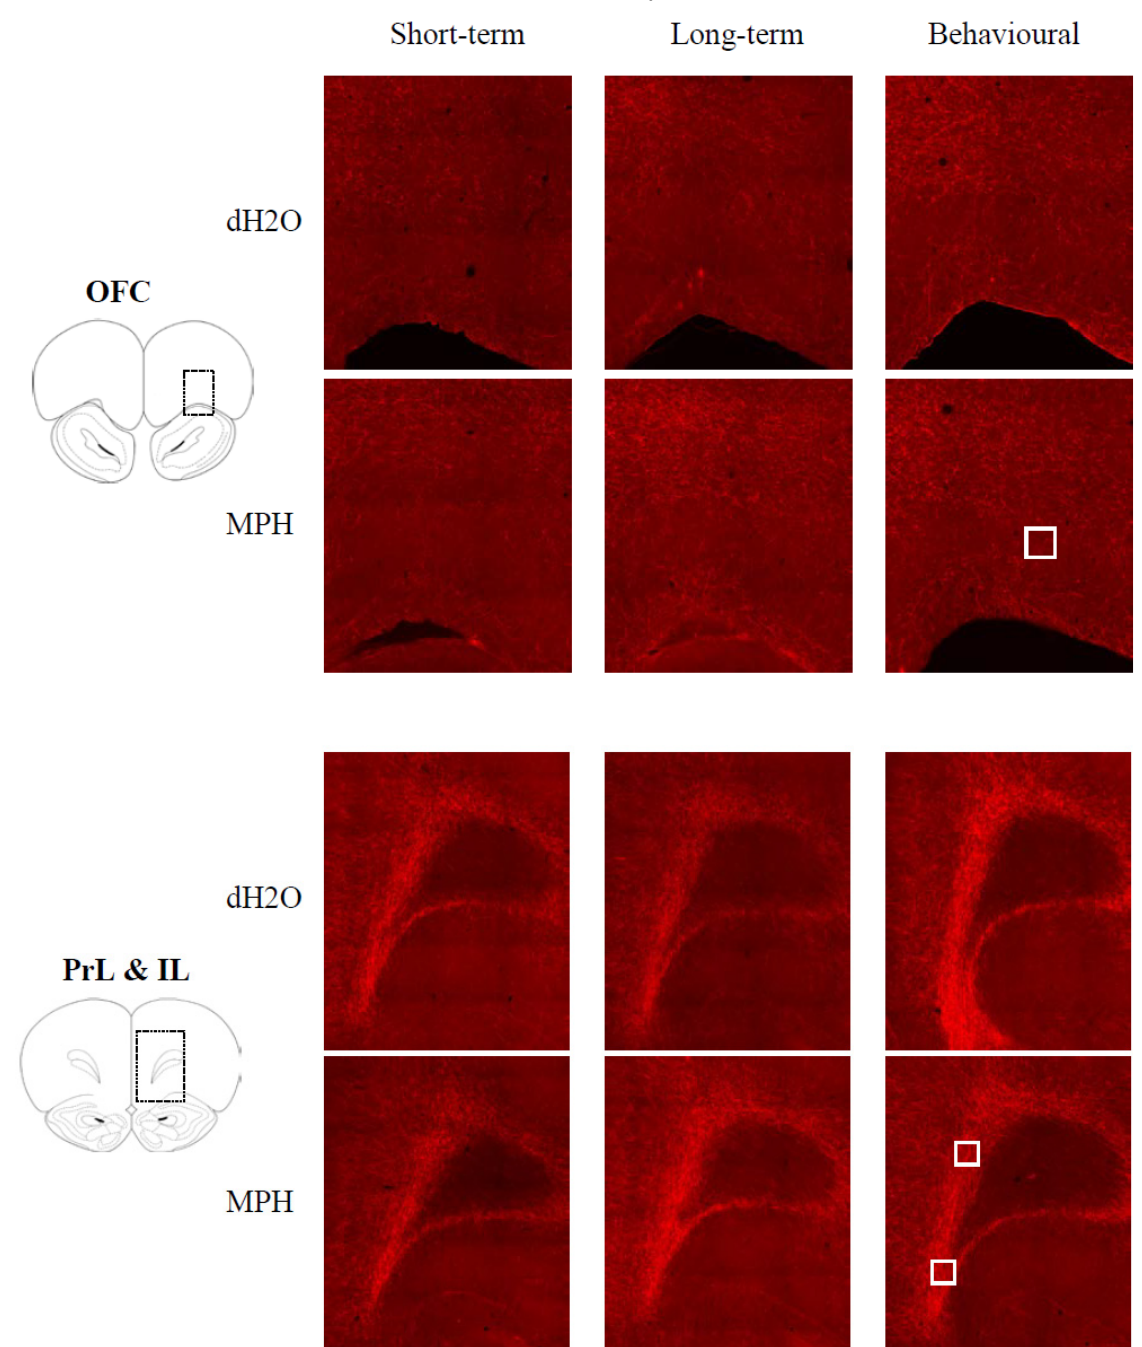
Figure 10. SHR: Images showing tyrosine hydroxylase-ir fibres in the orbitofrontal cortex (OFC), prelimbic cortex (PrL; dorsal) and infralimbic cortex (IL) following chronic treatment with either methylphenidate (MPH) or distilled water (dH O). Immunohistochemical 2 staining was conducted in the short- and long-term groups, 1 and 12 weeks after cessation of treatment, respectively, and following behavioural testing (12 weeks post treatment) in the behavioural group. The white square represents the analysis probe in each region of interest (50,000 µm 2 ). Images have been adjusted for